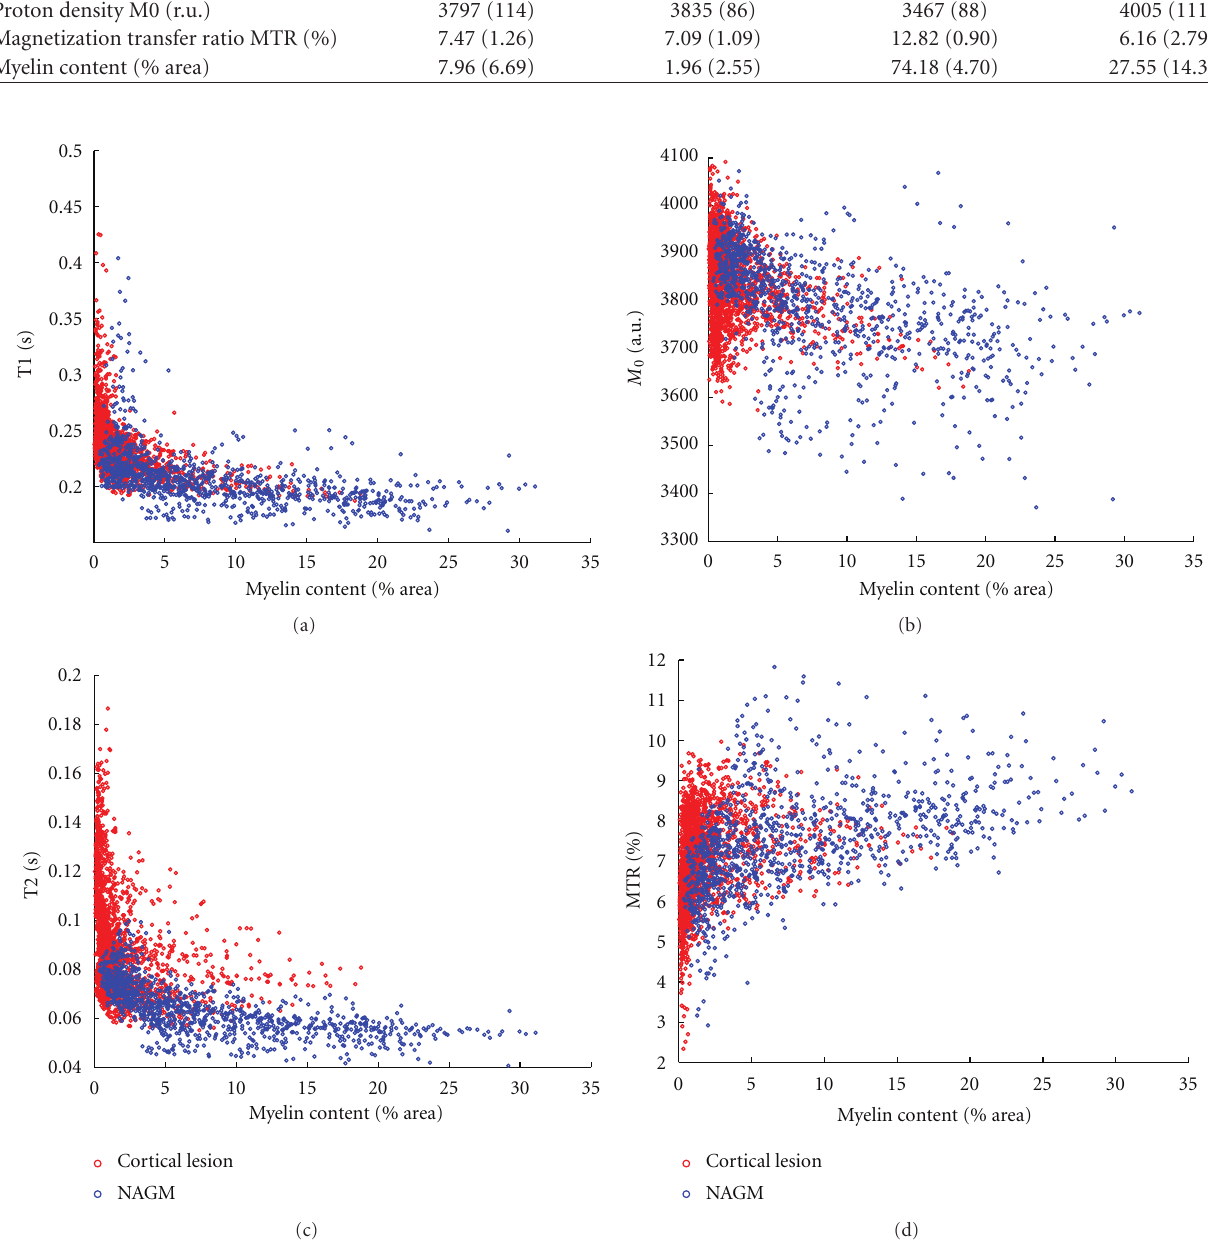
Figure 7: Scatter plots of the qMR parameters against myelin content. The red circles correspond to voxels labeled CL, and the blue circles to those labeled